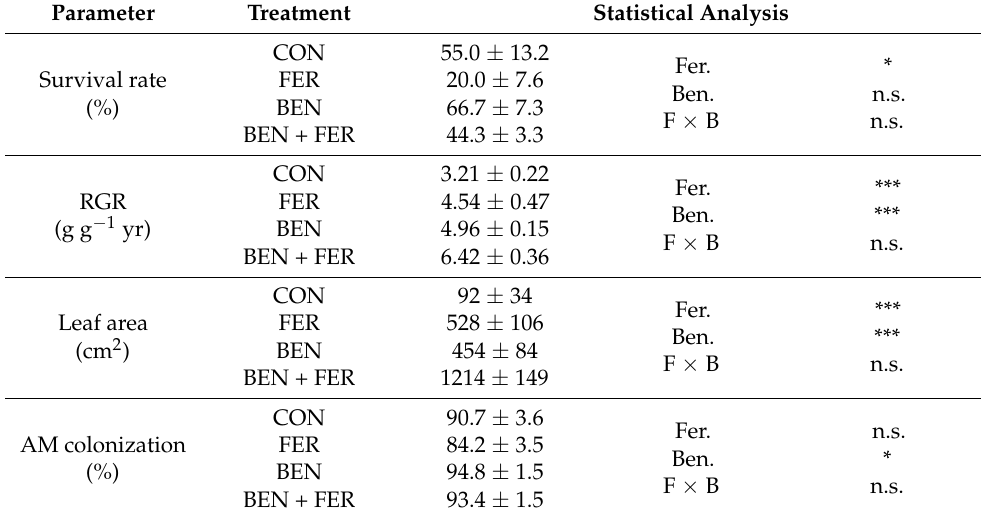
Table 4. Survival rate (Nov. 2015), growth rate (RGR), leaf area, and the percentage of AM fungi colonizing teak seedlings grown in the four treatments (mean ± SE, n = 3 for survival rate, and n = 12 for other parameters). Asterisks indicate significant differences by two-factor ANOVA. * = p < 0.05 and *** = p <